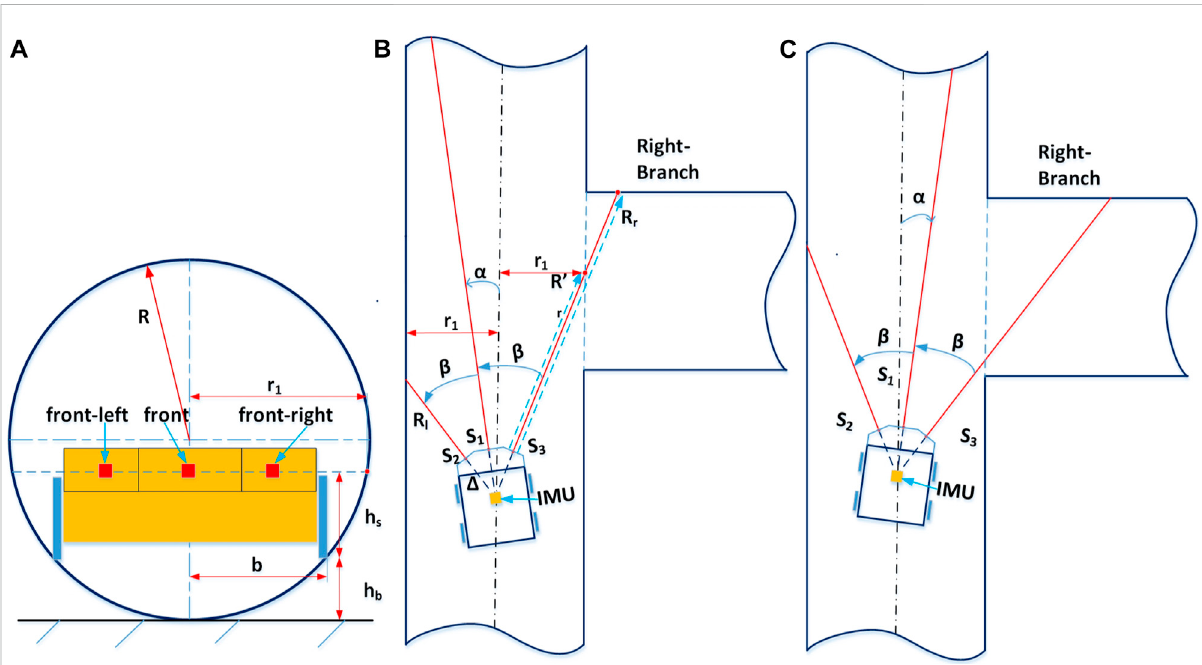
FIGURE 4 Principles ofestimating robotstate byrangesensors. Panel (A) showstherelativepositionoftheJoeyrobot baseintheround piperadiusR.r 1 is the half pipe width at the height that range sensor measuring ray points to. Panel (B) and Panel (C) depict the two typical orientations of the Joey approaching a right branch and the principles of determining a right branch with range sensors. In both cases, the right range value is signi fi cantly larger than the expected right range value for a straight